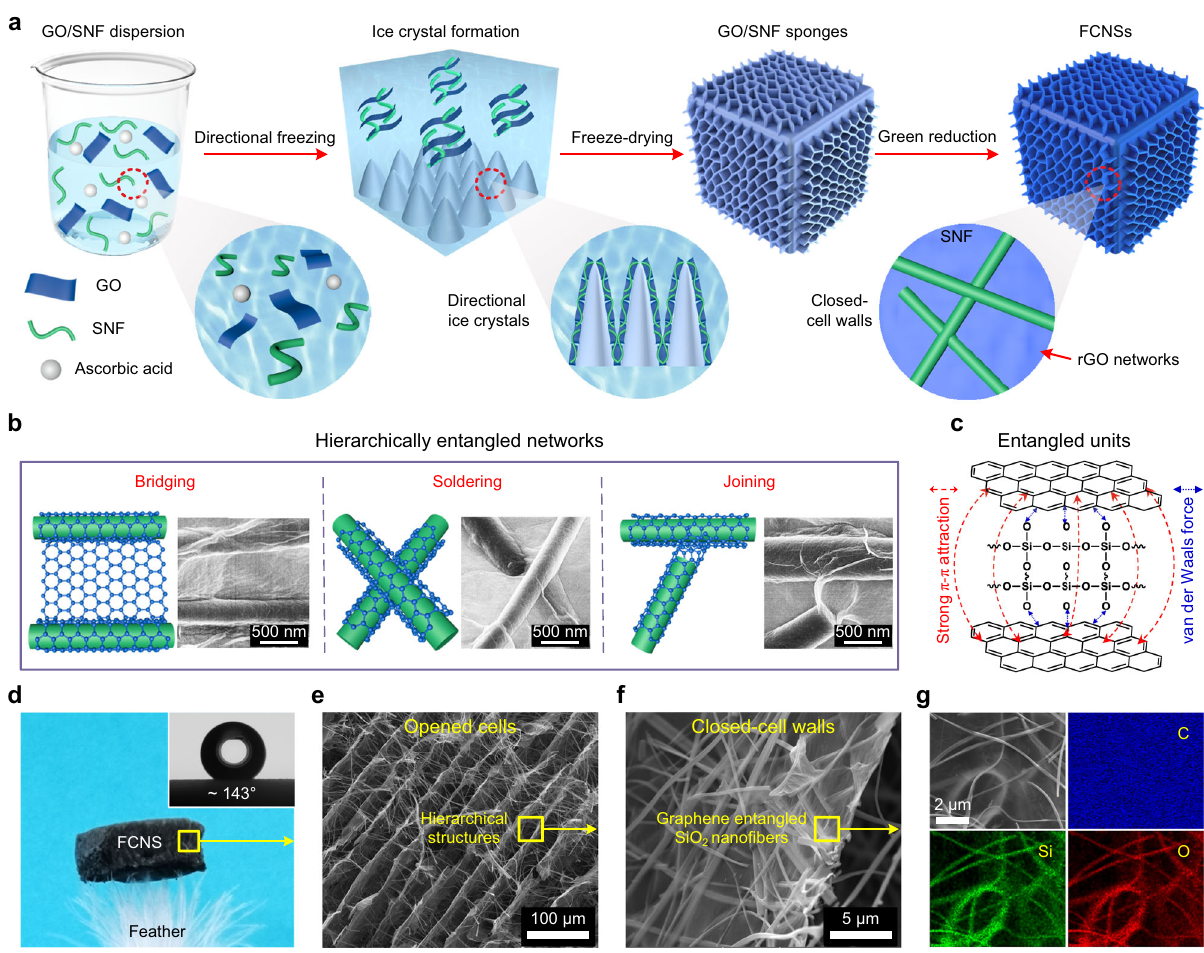
Fig. 1 Structure design and hierarchical architectures of FCNSs. a Schematic illustration of the fabrication of FCNSs. b Schematics and corresponding SEM images of the hierarchically entangled networks. c The entangled unit of the crosslinking networks. d An optical image showing an FCNS standing on the tip of feathers. Inset: photograph of a water droplet on the FCNS. e , f The microscopic structure of FCNSs at different magni fi cations. g SEM-EDS images of a closed-cell wall with corresponding elemental mapping